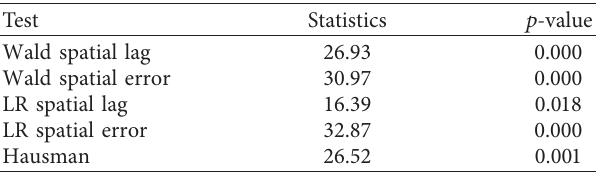
Table 5: Result of Wald, LR, and Hausman tests.